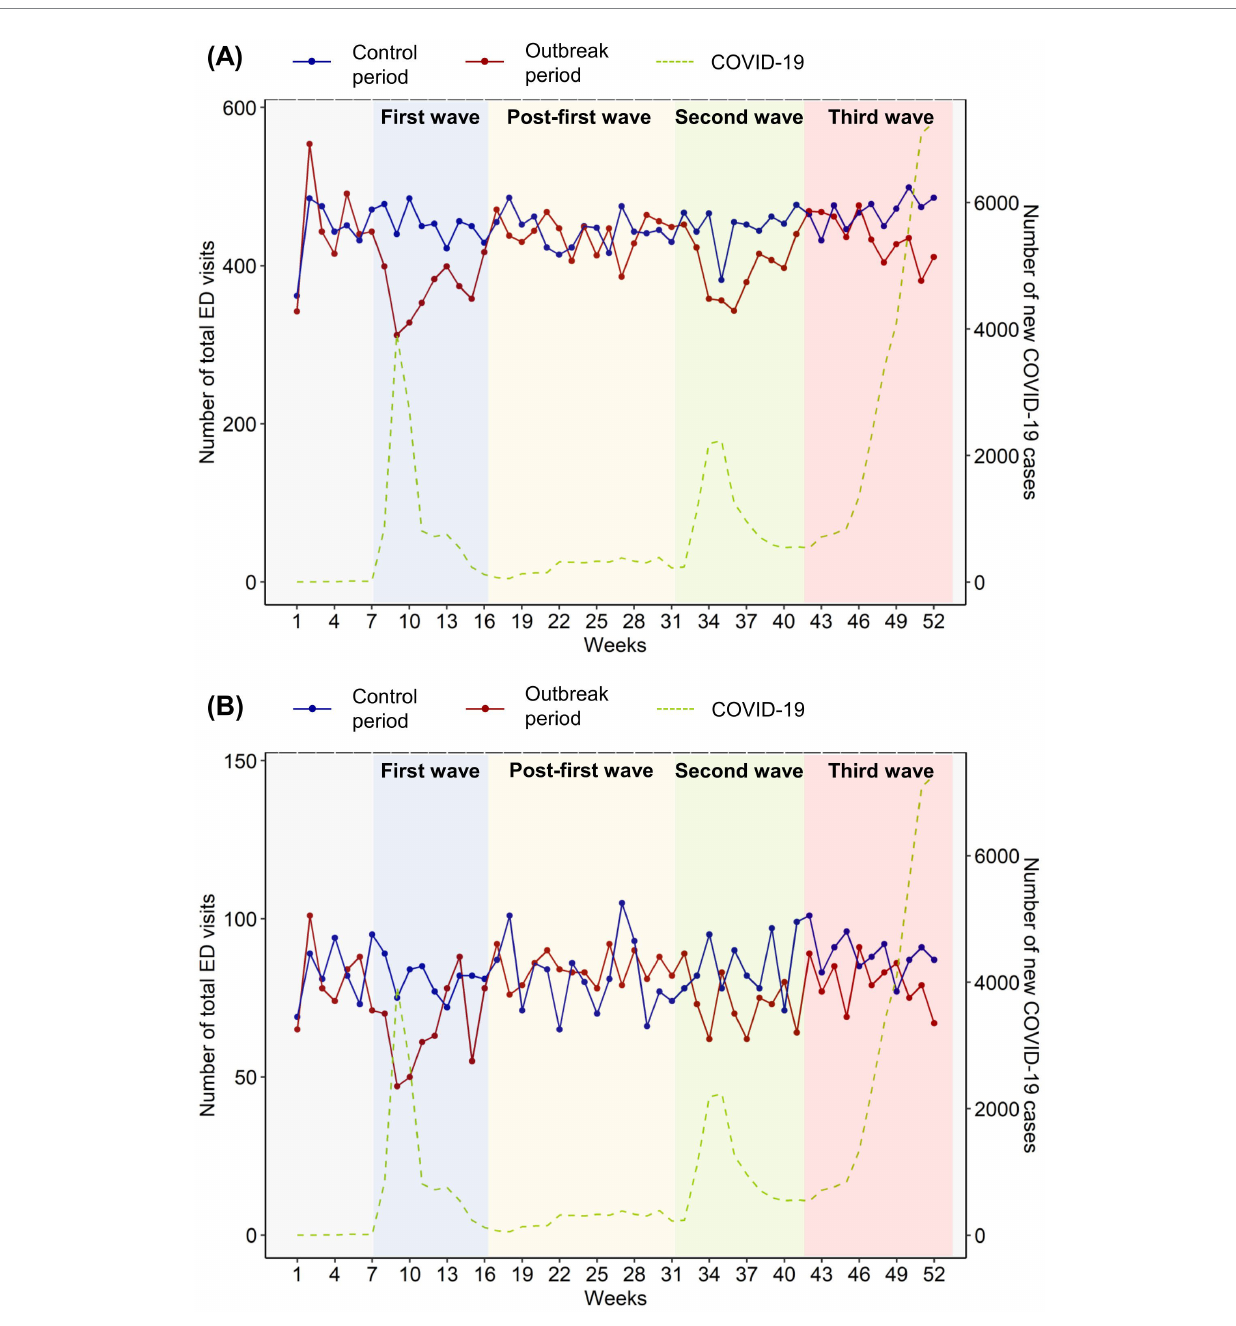
FIGURE 2 Frequency of emergency department (ED) visits (A) among all patients with acute myocardial infarction (AMI) during the outbreak (January 2020– December 2020) and control (January 2019–December 2019) periods and (B) among patients with AMI and underlying DM during the outbreak period. The blue line represents the weekly number of total ED visits during the control period, while the red line represents that of the same weeks during the outbreak period. The green dashed line indicates the total number of new COVID-19 cases in South Korea, regardless of ED visits or AMI or DM status. The blue background denotes the first wave of the COVID-19 outbreak in South Korea, while the green and pink backgrounds represent the second and third waves, respectively. ED, emergency department; AMI, acute myocardial infection; DM, diabetes